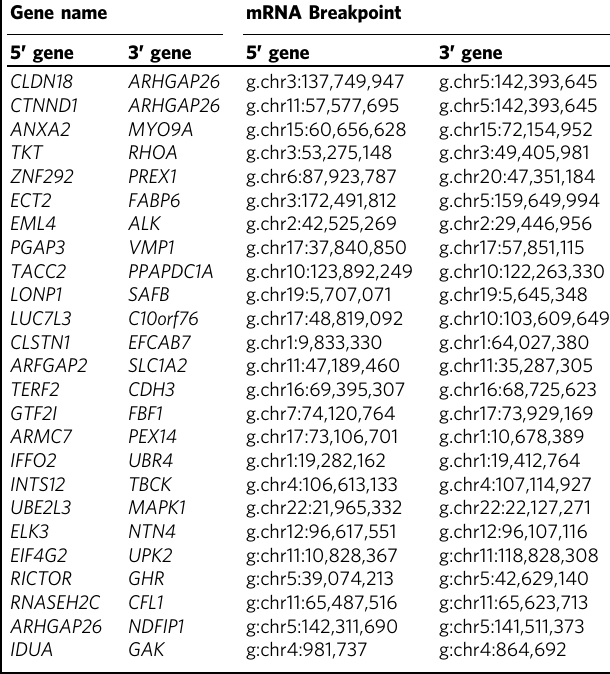
Table 1 In-frame fusions in a discovery set (n =